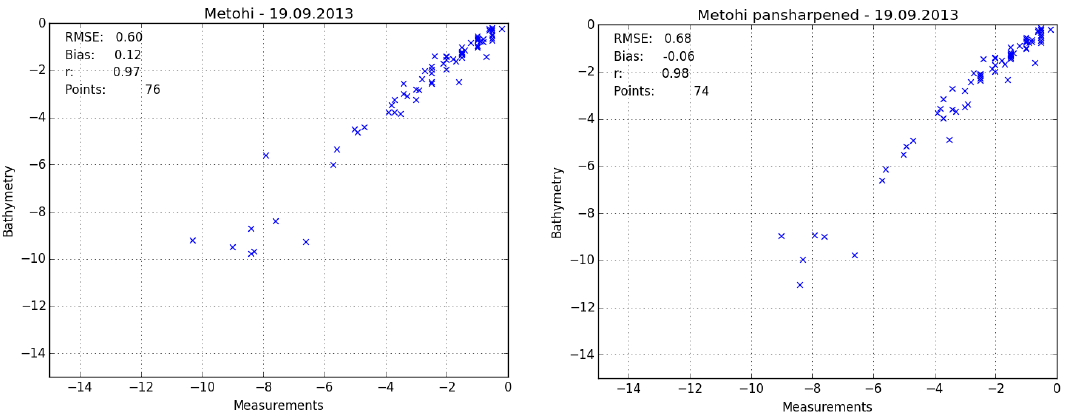
Figure 12: Comparison between field-measured bathymetry (x-axis) and satellite bathymetry (y-axis) over the Metohi penin- sula on 19.09.2013 using the original resolution image (left) and the pan-sharpened image